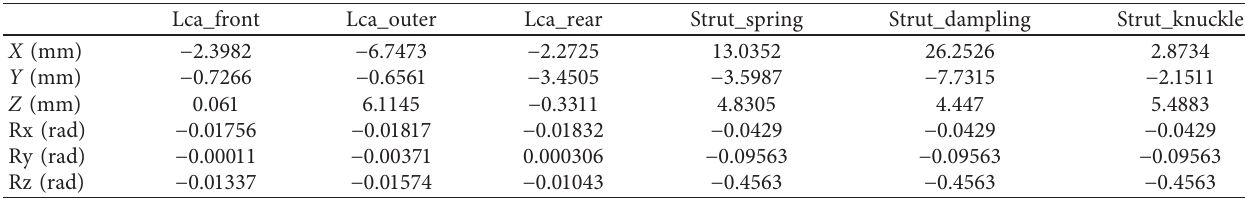
Figure 7: Rigid-flexible coupling model of front suspension assembly. (a) Front suspension assembly. (b) Chassis corner assembly. (c) Low control arm. Table 2: Partial displacement values of suspension components connection